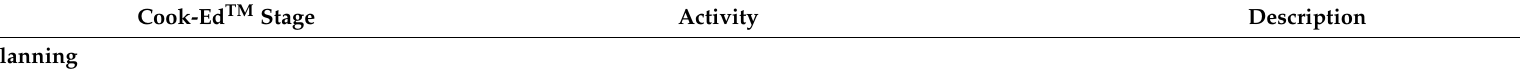
Table 1. Example of Cook-Ed TM model activities in the development of a cooking intervention for young adults with mild–moderate intellectual